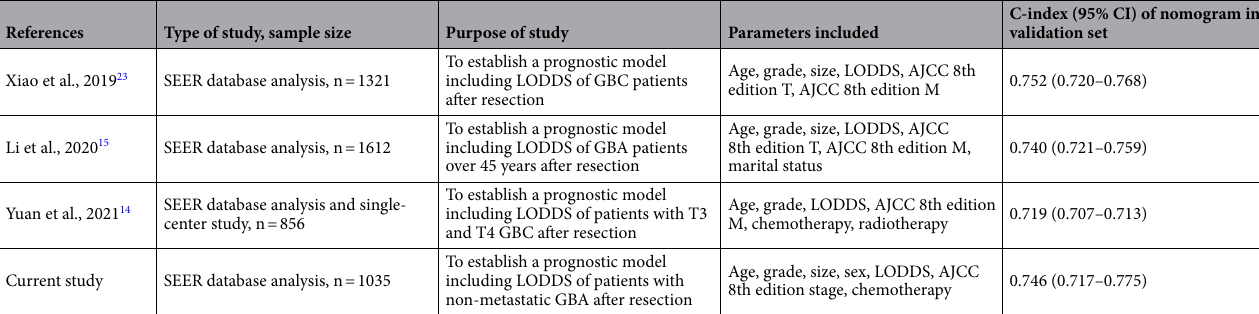
Table 4. Comparison of major studies that developed predictive nomograms included LODDS in GBC. LODDS log odds of positive lymph nodes, GBC gallbladder cancer, GBA gallbladder adenocarcinoma, CI confidence interval, SEER surveillance, epidemiology and end